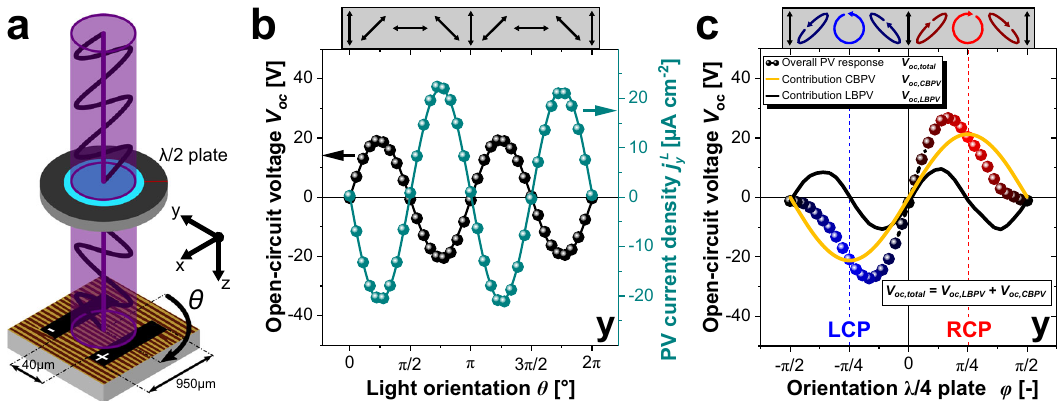
plate is Fig. 2 Photoelectrical measurements revealing LBPV and CBPV in BiFeO 3 thin fi lms. a Schematic of the experimental setup (not to scale): A λ 2 used to rotate the orientation of the incoming LP light (rotation described by θ ). The light propagates in z-direction and the electrodes run along the x- direction to enable photoelectrical measurements in y-direction. b LBPV measurement: V oc and j L as a function of the light orientation θ . The two-sided y arrows indicate the orientation of LP light. c CBPV measurement: λ plate placed before λ plate to enable modi fi cation of the light polarization state. The fl ip 4 2 of the light helicity due to the presence of the λ plate is considered in the experimental data. V oc as a function of the λ plate orientation ϕ . The light 2 4 ; 0 gÞ , to elliptical ð ϕ = 2 f ± π ; ± π ; 0 gÞ and to circular ð ϕ 2 f ± π polarization varies from linear ð ϕ 2 f ± π gÞ . The helicity of the light polarization changes from 2 2 4 4 left-handed ð(cid:2) π Þ (red). The overall V oc can be divided into the contribution from the CBPV (yellow solid line) and < ϕ < 0 Þ (blue) to right-handed ð 0 < ϕ < π 2 2 the LBPV (black solid